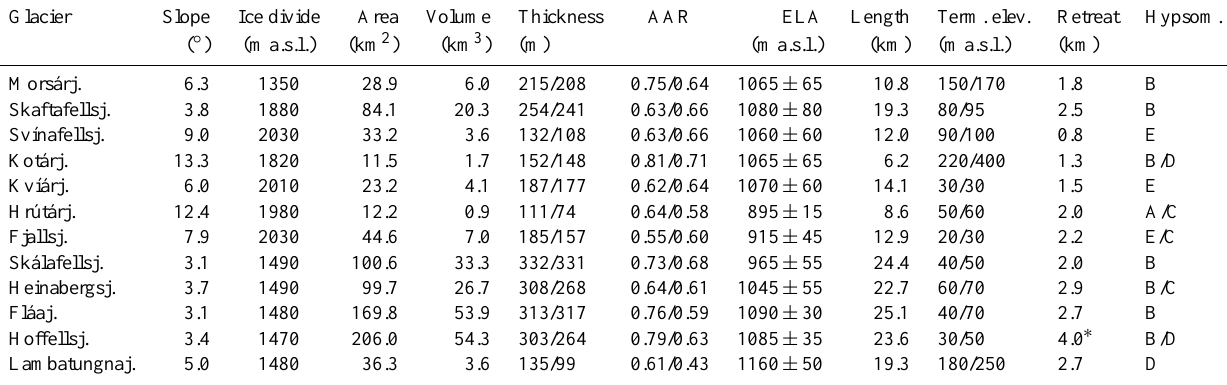
Table 1. Characteristics of the southeast outlet glaciers in 2010. Some glaciers have gently sloping accumulation and ablation areas, which are connected by ice falls, thus the mean slope is not representative for the entire profile. The ELA is presented as the averages of the years 2007–2011 with the standard deviation. Average ice thickness, the AAR and terminus elevation are presented in ∼ 1890 and 2010. Glacier Slope Ice divide Area Volume Thickness AAR ELA Length Term. elev. Retreat Hypsom. ( ◦ ) (ma.s.l.) (km 2 ) (km 3 ) (m) (ma.s.l.) (km) (ma.s.l.) (km)